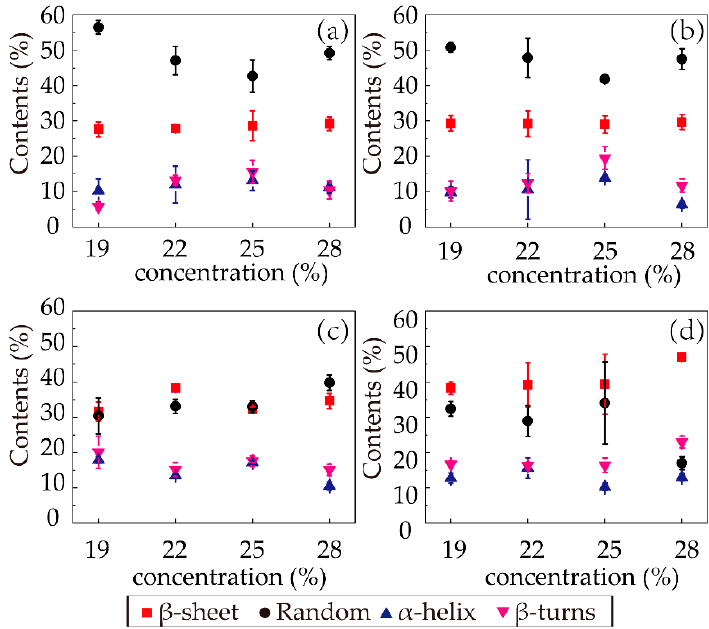
Figure 6. Contents of secondary structures in the RSF samples: (a) F1; (b) F2; (c) E1; (d) E2.